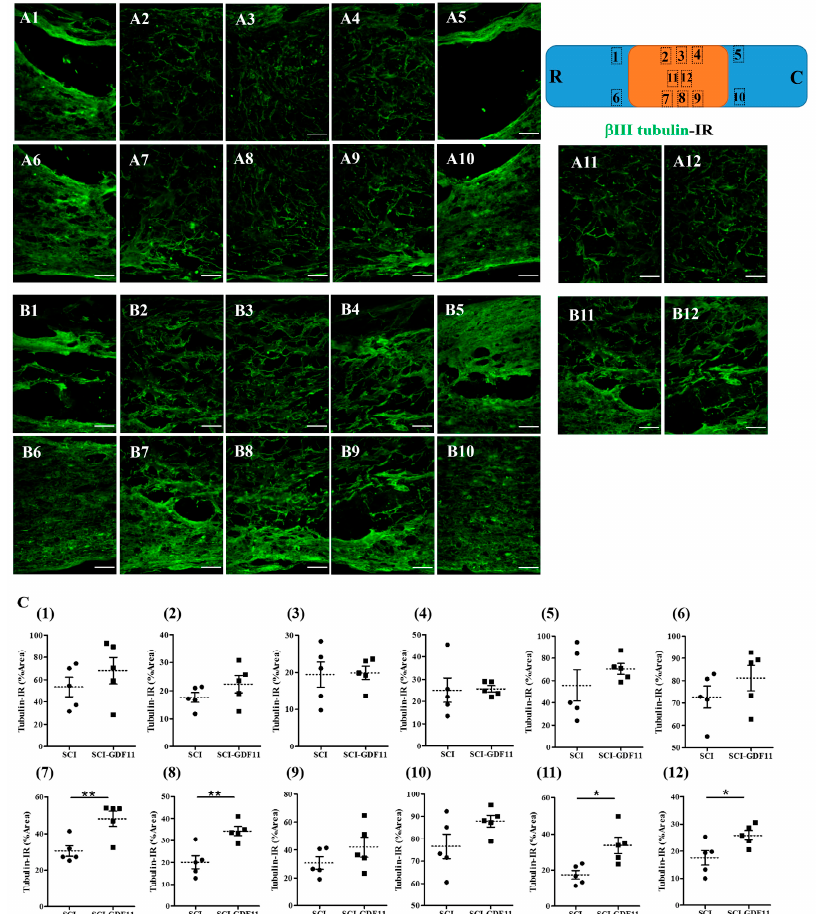
Figure 8. β III Tubulin-immunoreactive nerve fibers in the thoracic spinal cords of SCI rats 6 weeks after injury. ( A ) Representative images of longitudinal spinal cord sections in an SCI rat. ( B ) Rep- resentative images of spinal cord sections in a GDF11-treated SCI rat. ( C ) Quantification of β III tubulin-positive axons shown in area (1–12) of ( A ) or ( B ) panel, from control- or GDF11-treated, respectively, in spinal cord sections. The upper-right scheme shows segments of the thoracic spinal cord (T7~T9; R: rostral; C: caudal). The locations of tubulin-IR photo taken in area (1–12) are depicted. Note the significant increase in tubulin-positive nerve fibers in the GDF11-treated groups in areas (7), (8), (11), and (12) at 6 weeks post-injury. GDF11, 24 µ g/rat, was administered to SCI rats through tail vein injection after spinal cord contusion. After 6 weeks, immuno-fluorescence positive areas of β III tubulin were detected in the longitudinal sections at the epicenter of the spinal cord. The results are reported as mean ± SEM from 5 rats per group. Statistical significance is evaluated using unpaired Student t -test. * p < 0.05, ** p < 0.01, respectively, SCI versus SCI-GDF11. N = 5 rats per group. Magnification: 200 × . Scale bar: 100 µ